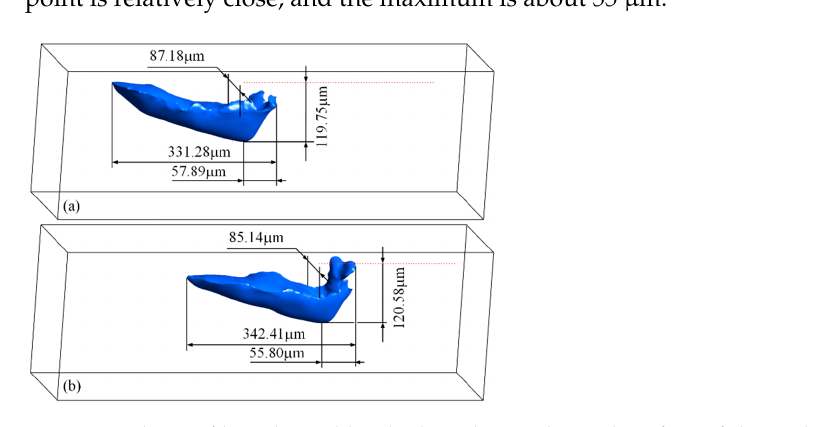
shown in Figure 4b. The temperature of points B and D located within the laser spot rises almost simultaneously, while the peak temperature at point B is slightly higher due to